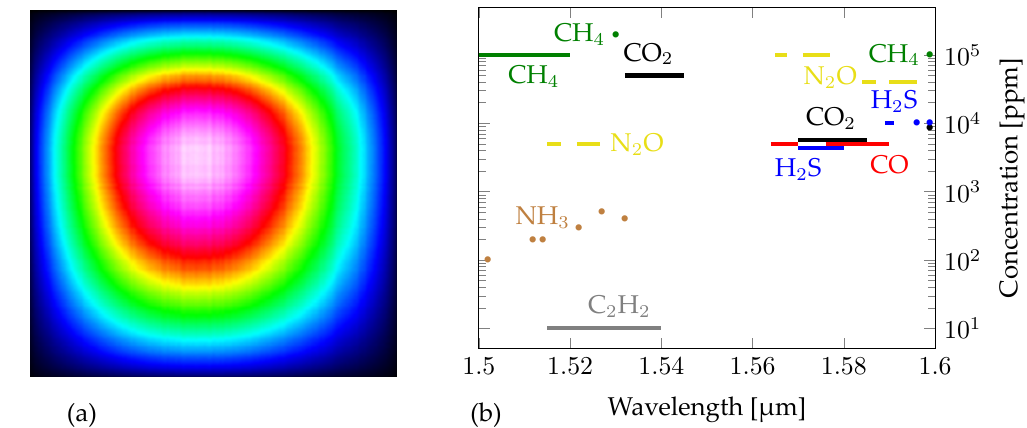
Figure 3. ( a ) Beam profile measured after the output of the hollow core fiber. It can be seen that the fundamental mode is the predominant mode transmitted through the fiber. ( b ) Detectable concentrations of several gases that have absorption lines in the range exploitable by telecom technology photonic integrated circuits. The shown concentrations correspond to signal strengths of 0.1% and ∼ assume a propagation length of 1 m in neutral background at atmospheric pressure at room temperature. Lines in the diagram represent a close set of multiple usable absorption lines, whereas a dot refers to a single line. Table 1. Estimated link loss per transition element for the main path in the setup, i.e., from the on-chip distributed Bragg-reflector (DBR) laser to PM1 on the light wave measurement system (LWMS), as shown in Figure 1. Element Loss [dB] Occurence Total [dB]